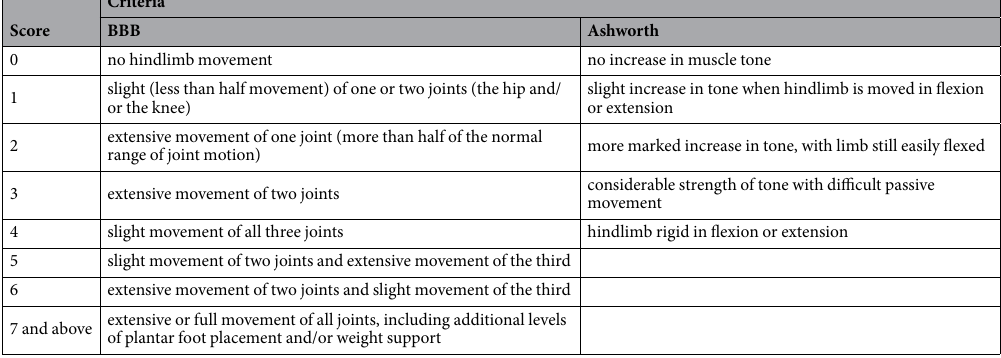
Table 1. Scoring for the BBB and the Ashworth rating scales in unilateral SCI in